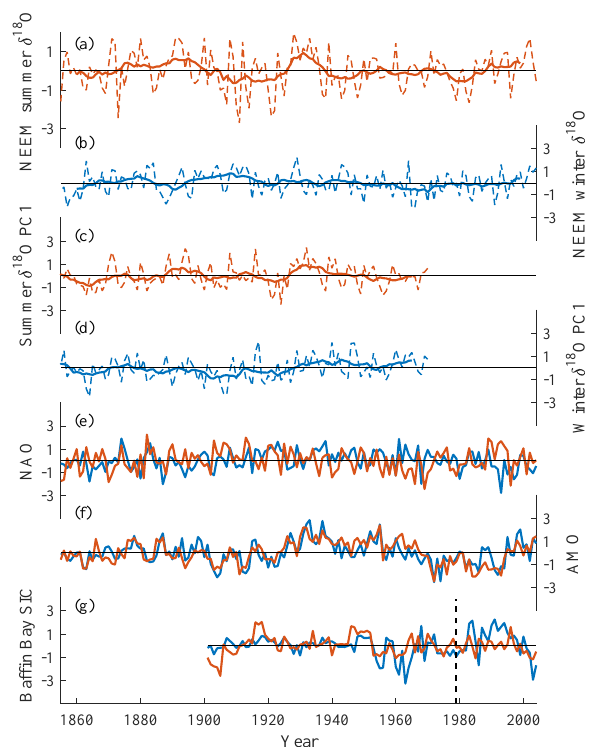
Figure 4. (a, b) The NEEM seasonal δ 18 O identified in this study. The dashed line and bold line show annual and 11-year averaged data, respectively. (c, d) The Greenland seasonal δ 18 O PC1 ex- tracted from ice cores in central/southern Greenland (Vinther et al., 2010). The dashed line and bold line show annual and 11-year av- eraged data. (e) The NAO indices calculated from 20CR reanalysis data using principal component analysis. (f) The AMO indices cal- culated from 20CR reanalysis data based on the method by Tren- berth and Shea (2006). (g) The averaged SIC over Baffin Bay ex- tracted from COBEsic (Hirahara et al., 2014). The dashed line in- dicates the start year of satellite observation (1979). All red lines show summer, and blue lines show winter. All data are normalized and